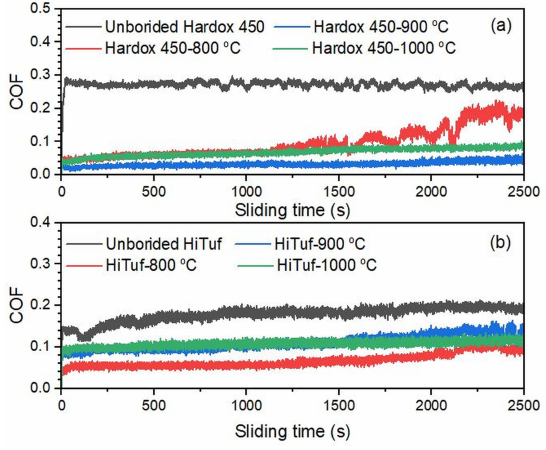
Figure 6: The change in the COFs of samples depending on sliding time; (a) Hardox 450, and (b) HiTuf steel.